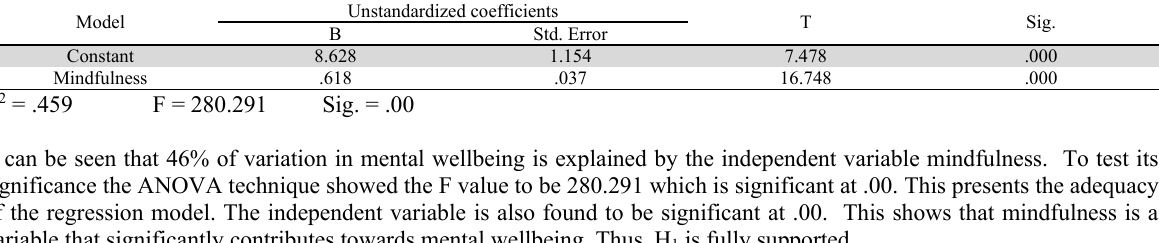
Relationship between Mindfulness and Mental wellbeing Model